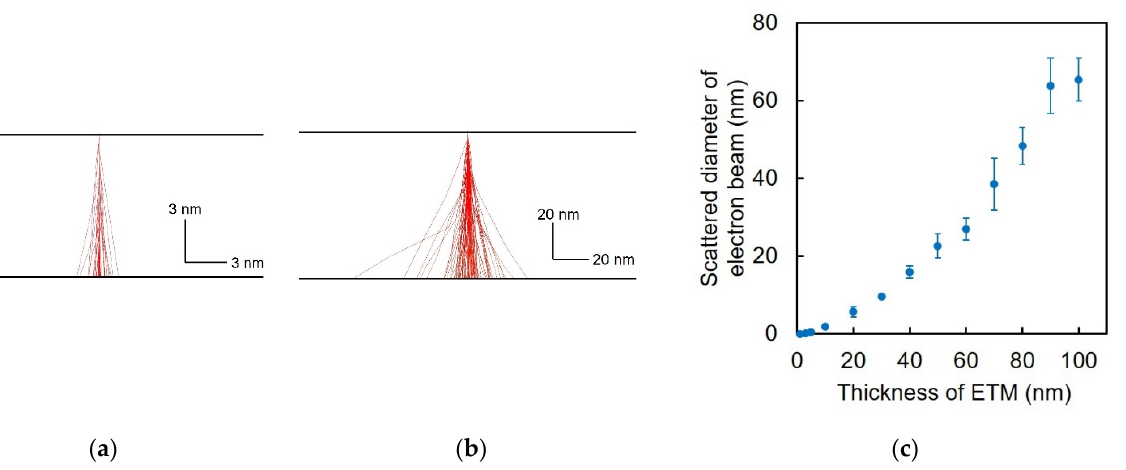
Figure 2. Monte Carlo simulation of electron beam scattering in a Si 3 N 4 ETM. ( a ) Electron beam scattering in the Si 3 N 4 membrane of 10 nm in thickness. ( b ) Electron beam scattering in the Si 3 N 4 membrane of 80 nm in thickness. ( c ) Relationship between the thickness of the Si 3 N 4 ETM and scattering diameter of electron beam at 17 kV in accelerating voltage.